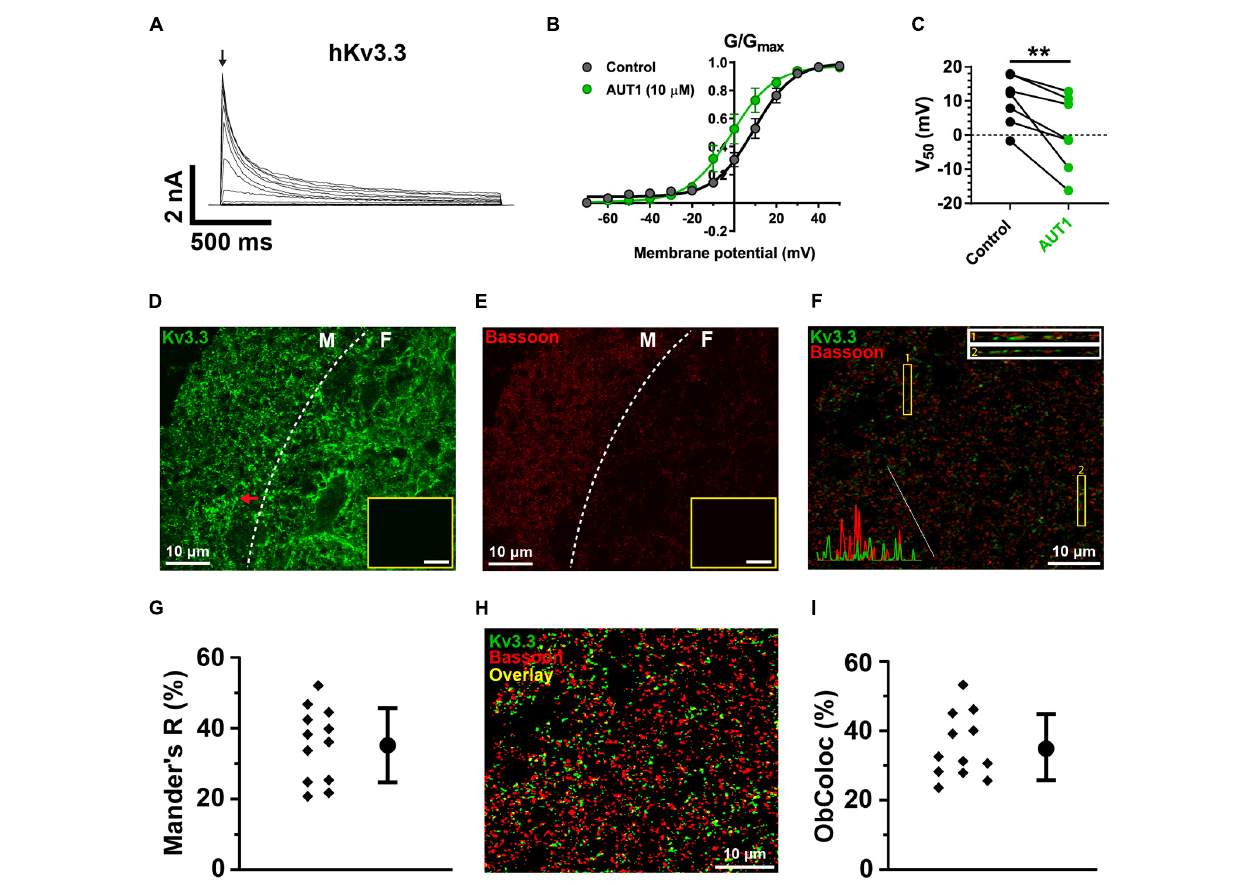
FIGURE 6 | Kv3.3 K + channels are present in a third of parallel fiber pre-synaptic terminals. (A) Whole-cell voltage clamp recordings showing outward currents recorded from HEK 293 cells stably expressing Kv3.3 K + channels (hKv3.3) in response to voltage steps from –70 to 50 mV in 10 mV increments. (B) Normalized conductance (G/G max ) curves plotted as a function of the step potentials (mean ± SEM) in the control (black) and AUT1 (green) conditions. Currents were measured at the initial peak of the outward currents (arrow in panel A ). Data were fitted using a Boltzmann function. (C) AUT1 caused a significant shift in V 50 to more negative voltages ( n = 7). (D) Confocal microscopy image of a sagittal brainstem slice (12 µ m) showing immunolabeling of Kv3.3b K + channels in the DCN molecular (M) and fusiform (F) layer (separated by a dashed line). Red arrow indicates example fluorescence punctum. (E) Same area is labeled with the pre-synaptic active zone protein Bassoon. (D,E) Insets show images of the molecular layer in which the primary antibody was omitted (scale bar = 20 µ m). (F) Confocal image of the molecular layer showing the joint expression of Kv3.3 K + channels (green) and Bassoon (red). Top right: Rectangular insets numbered 1 and 2 are z -axis representations of the images within yellow boxes (labeled 1 and 2). Bottom left: Line plot overlays show the fluorescence intensities (arbitrary units) for the green and red channels along the diagonal white line. (G) Mander’s R correlation coefficient showing the percentage of red fluorescence overlapping with green fluorescence for 12 fields from 3 slices ( N = 2). (H) Image shown in panel (F) following filtering and fluorescence separation between green (Kv3.3) and red (Bassoon) objects, allowing for object-based co-localization (where yellow represents the overlap between green and red objects, estimated at 27.3% for this image). (I) Object-based co-localization for 12 fields from 3 slices ( N = 2). (G,I) Error bars = SD. ** p <